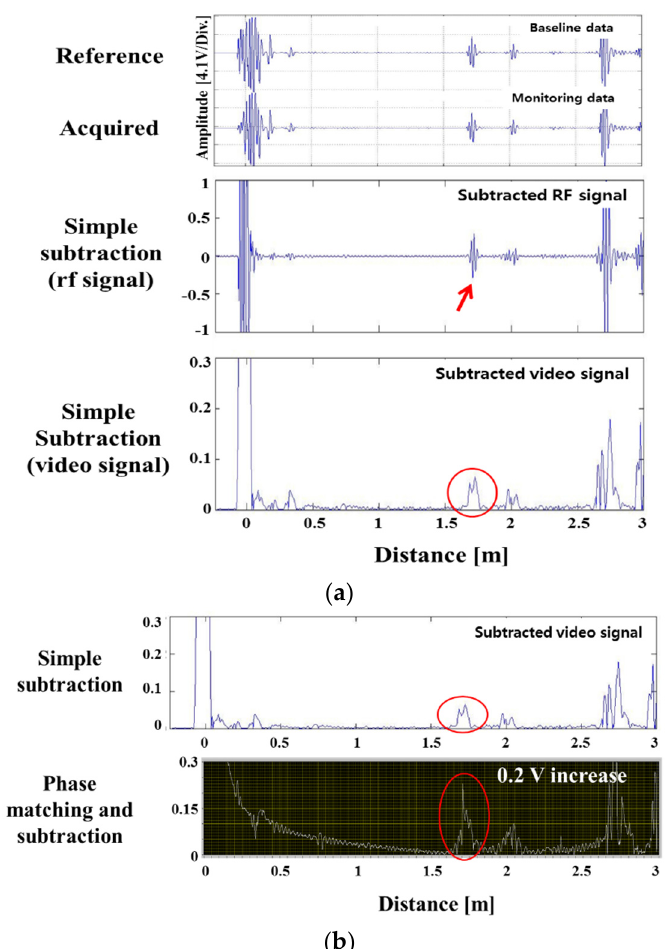
Figure 9. ( a ) Defect signals of surface corrosion in a pipe weld with depths, ( b ) comparison of subtraction between simple elimination and phase matching-subtraction; signals of corrosion in a pipe weld (defect ratio: 1.66%).